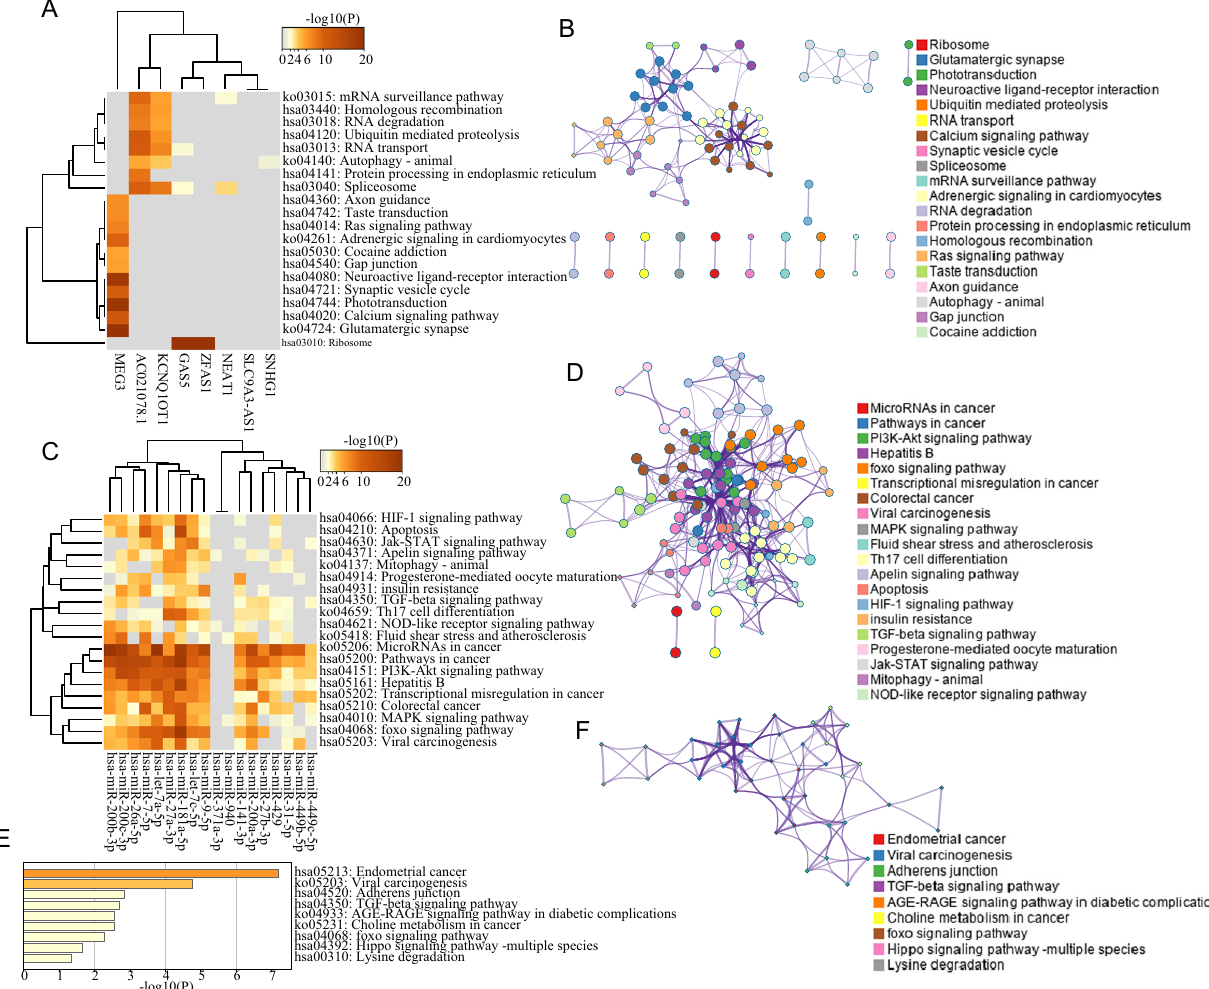
Fig. 3 Functional analysis of novel UM-related susceptibility genes. Clustered heatmap of top 20 enriched pathways for novel UM-related risk A lncRNAs and C miRNAs, colored by P-values. Network of enriched pathways are colored by functional classes and nodes that share the same cluster are typically close to each other for novel UM-related risk B lncRNAs, D miRNAs and F mRNAs. E Metascape bar graph for viewing enriched pathways of mRNAs, colored by P -values. UM uveal melanoma, lncRNA long non-coding RNA, miRNAs microRNA, AGE-RAGE advanced glycation end products-receptor of